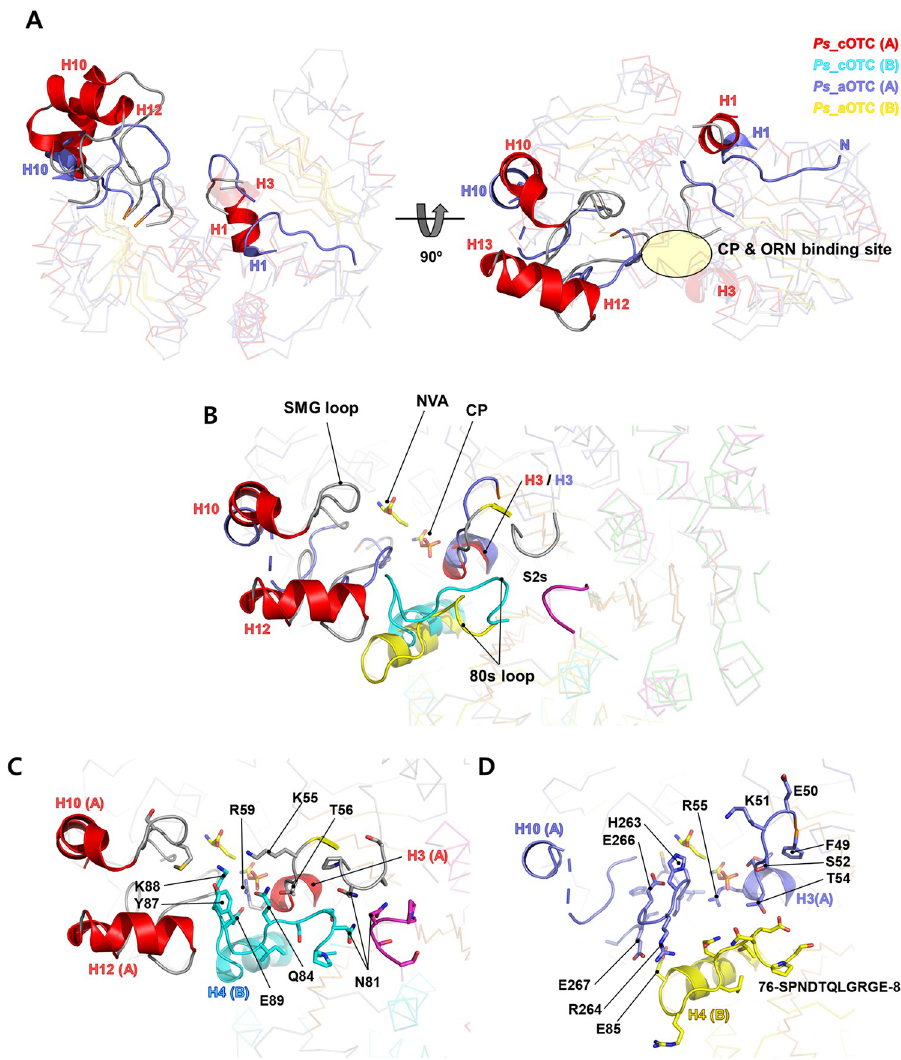
Fig 5. Structural comparison of Ps _cOTC and Ps _aOTC. (A) Structural superposition between monomeric Ps _cOTC (red and grey) and Ps _aOTC (purple-blue) are shown in ribbon representation. The different regions between the two OTCs are highlighted with cartoons and thick lines. The catalytic pocket is shown as a yellow circle. (B) Active sites of Ps _cOTC and Ps _aOTC with neighboring monomers (chain B). The CP and NVA from V . vulnificus (PDB code: 4H31) are indicated by yellow sticks. Detailed structural features of Ps _cOTC (C) and Ps _aOTC (D) from Fig 5B with the same orientation. The monomer used is the same as for Ps _cOTC and Ps _aOTC in Fig 3.